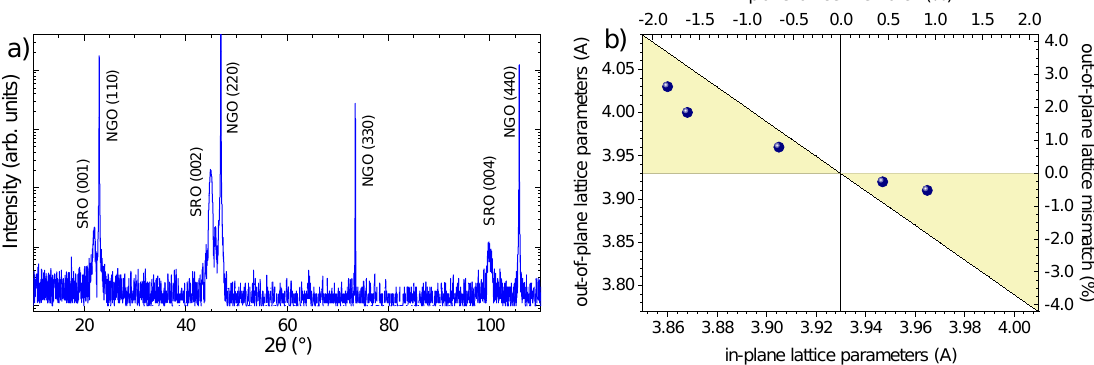
Figure 2. ( a ) symmetrical θ –2 θ scan of a SRO film grown on a (110)-oriented NGO substrate; ( b ) out-of-plane vs in-plane lattice parameters for the investigated SRO samples; the expected out-of-plane lattice deformation due to the elastic response of the lattice parameters as a function of a biaxial strain obtained by the Equation (1) is enlightened by the yellow